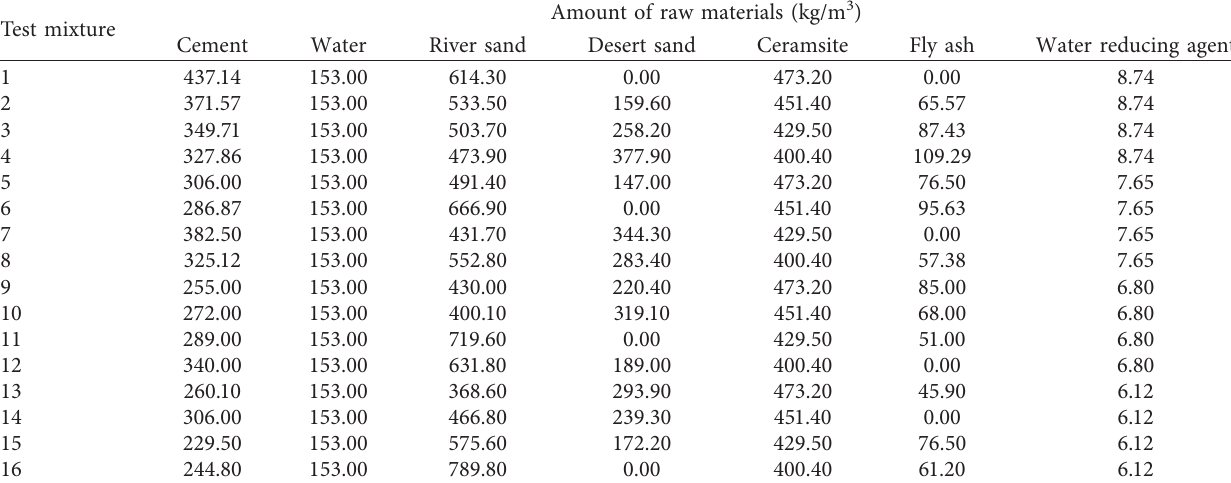
Table 7: The dosage of each material.